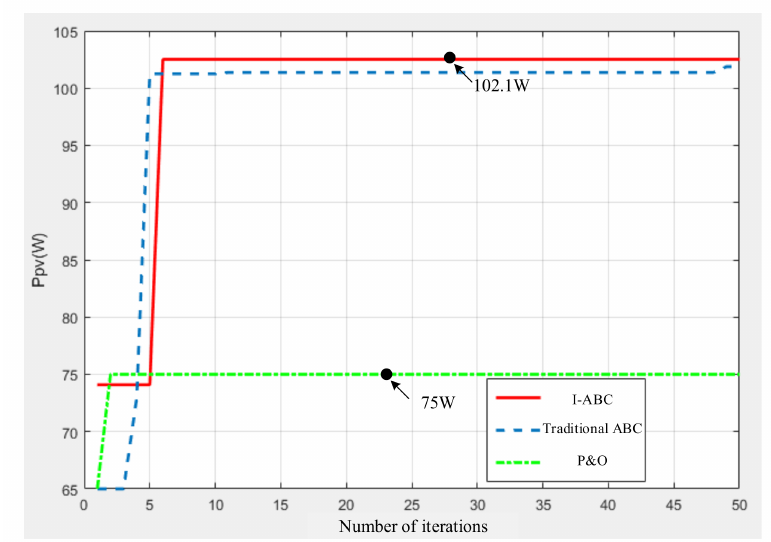
Figure 11. Comparison of simulation results for the MPPT in Case 3. P-V Characteristic Curve (intensity of insolation: 534W/m 2 }